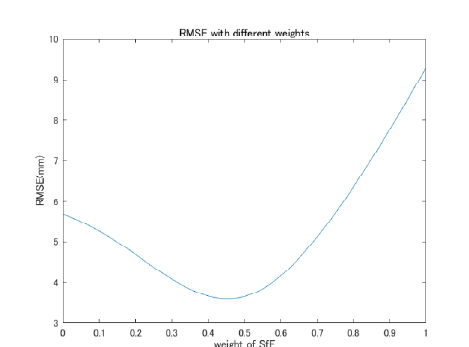
Figure 19. Applications of the proposed